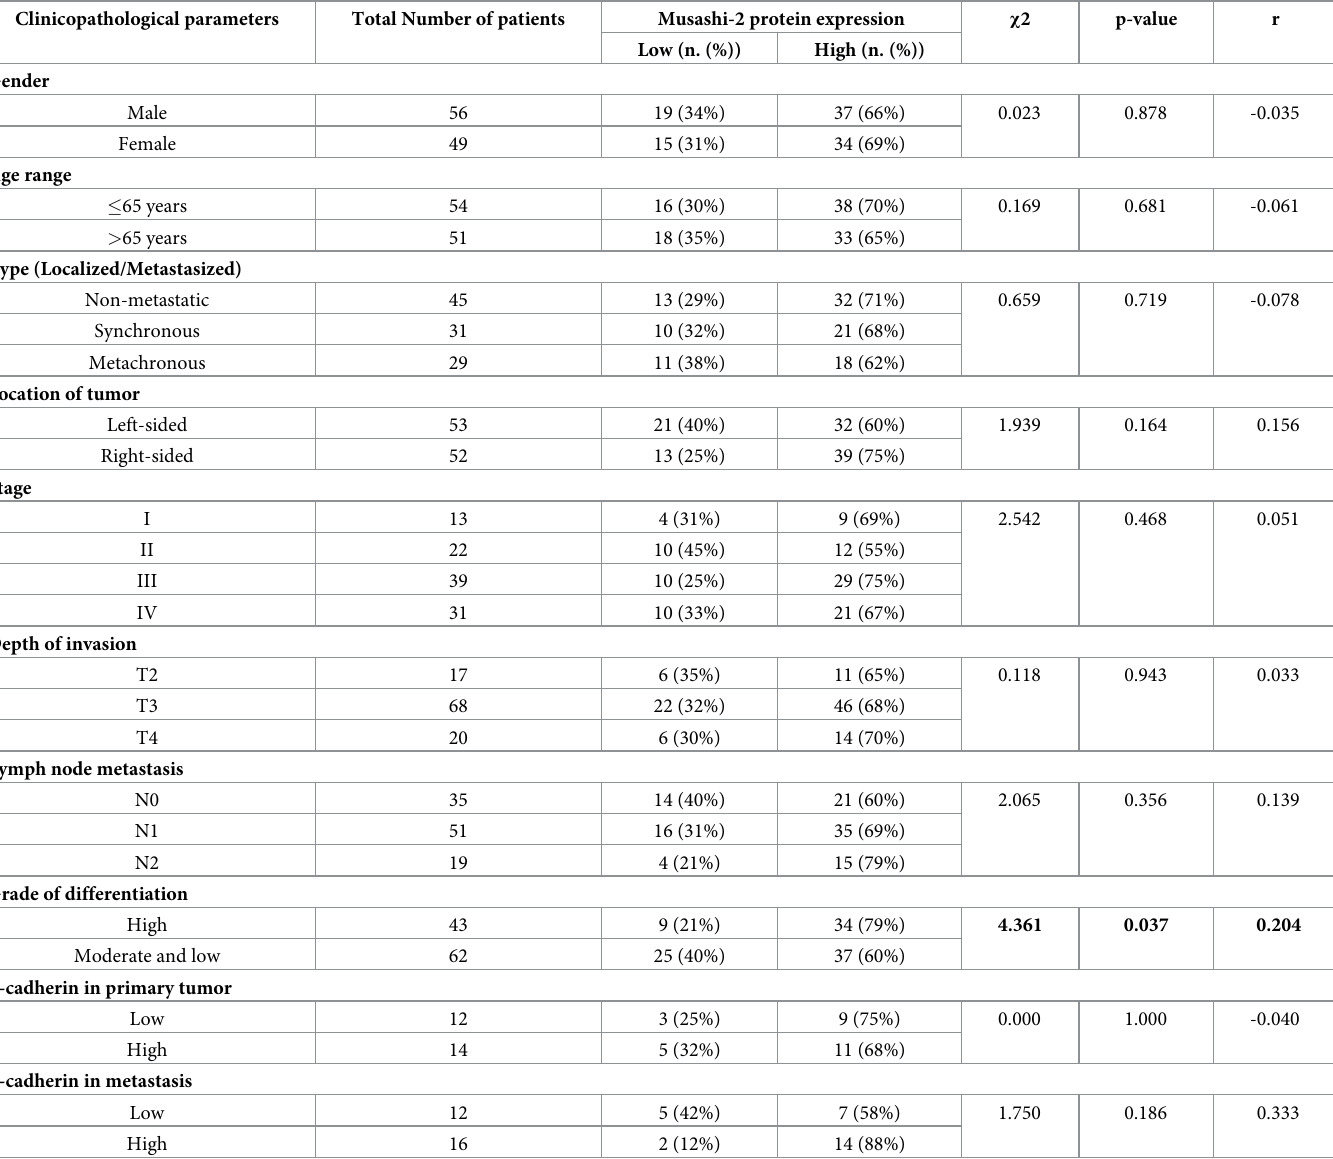
Table 1. Comparison of the frequencies of qualitative indicators in primary colorectal tumors with low and high expression of MSI2 (n = 105). Clinicopathological